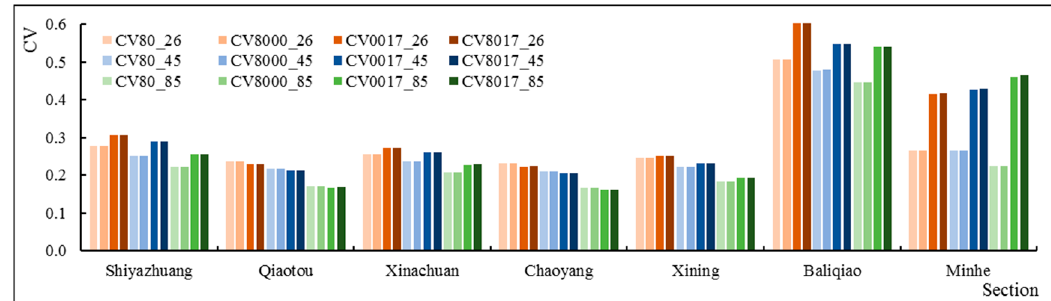
Figure 15. Annual runoff CV under different slope ecological restoration scenarios and different climate scenarios.